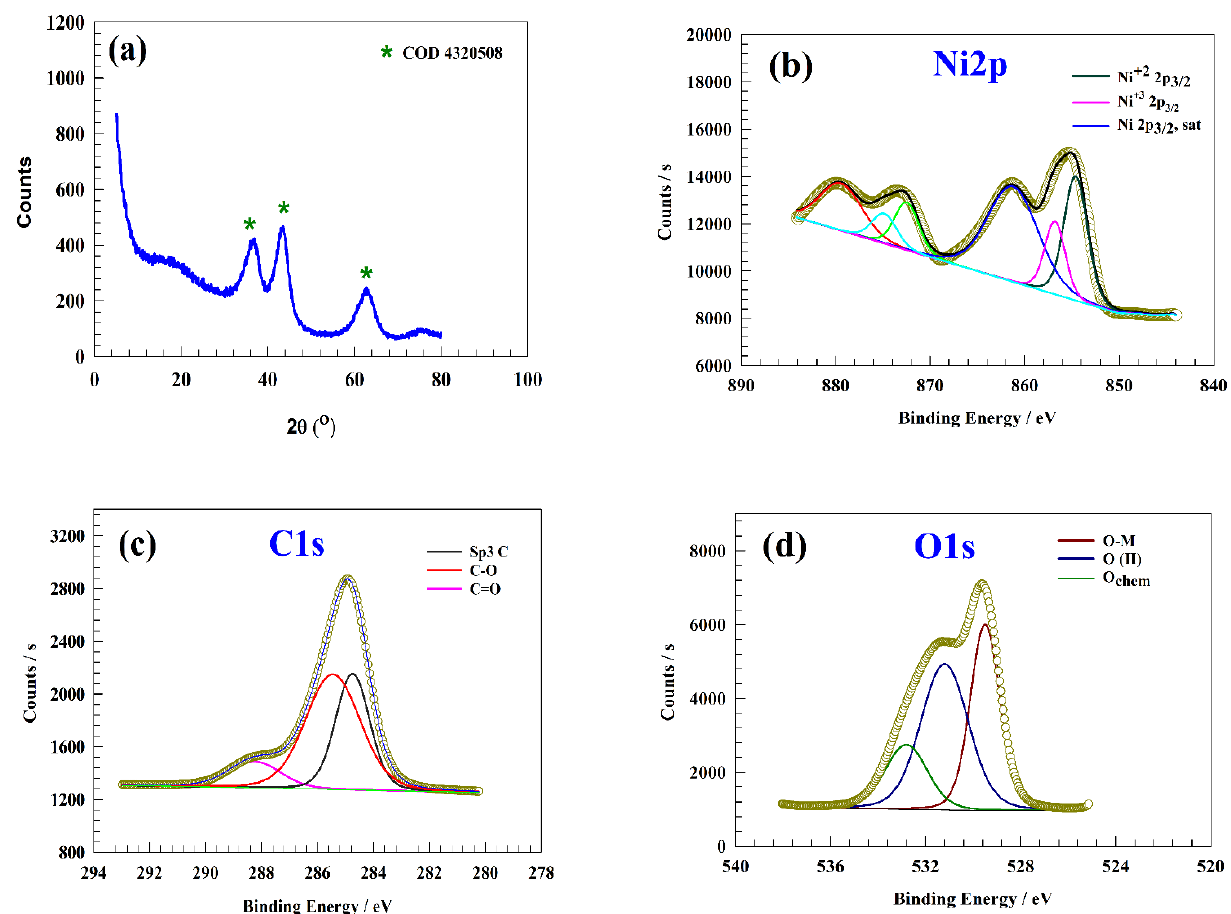
Figure 1. ( a ) XRD pattern of NiOnF, XPS of NiOnF spectra of ( b ) Ni2p, ( c ) C1s, and ( d ) O1s.